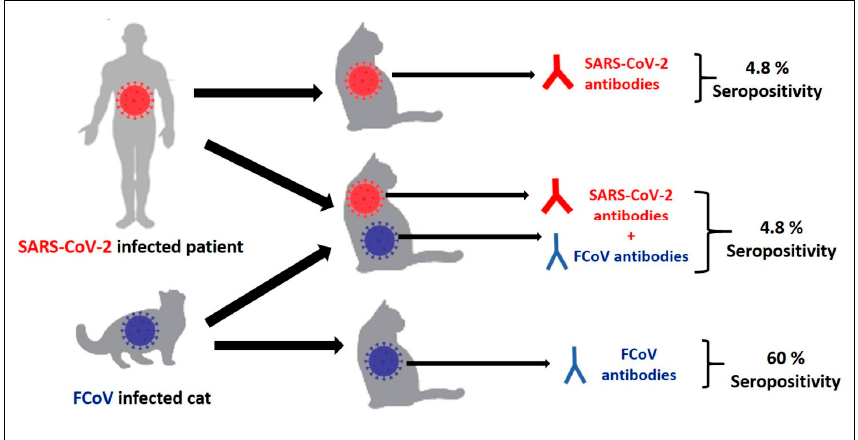
Figure 3. Seropositivity of cats’ population (n = 83) for feline coronavirus (FCoV) alone (60%), SARS-CoV-2 alone (4.8%) and both FCoV and SARS-CoV-2 together (4.8%).